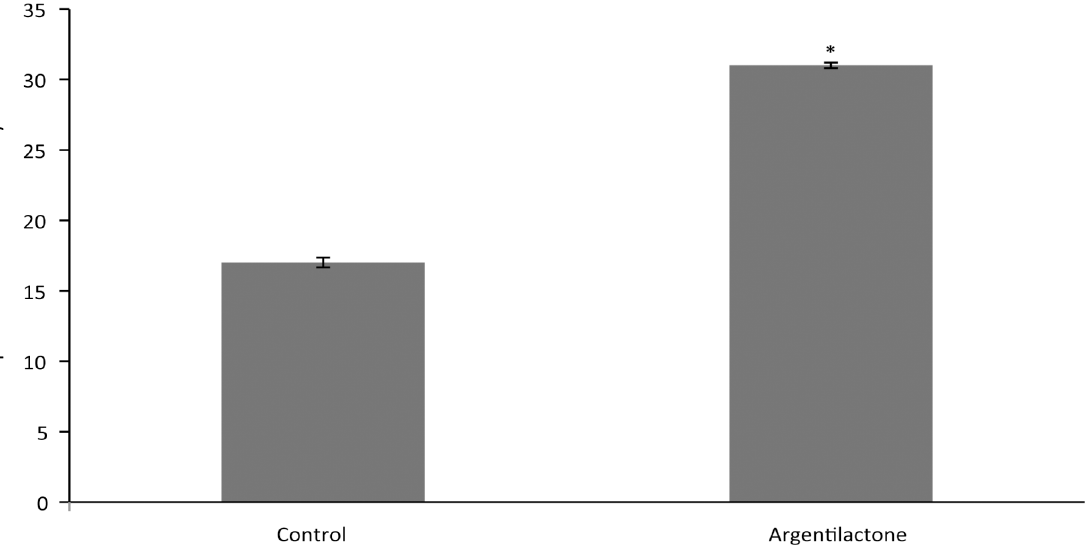
Fig 6. Superoxide dismutase activity. Yeast cells were grown in the presence of argentilactone for 6 h, and total proteins were extracted and used to measure superoxide dismutase activity. Student ’ s t test was used for statistical comparisons, and the observed differences were statistically significant ( p < 0.05). The error bars represent the standard deviation of three biological